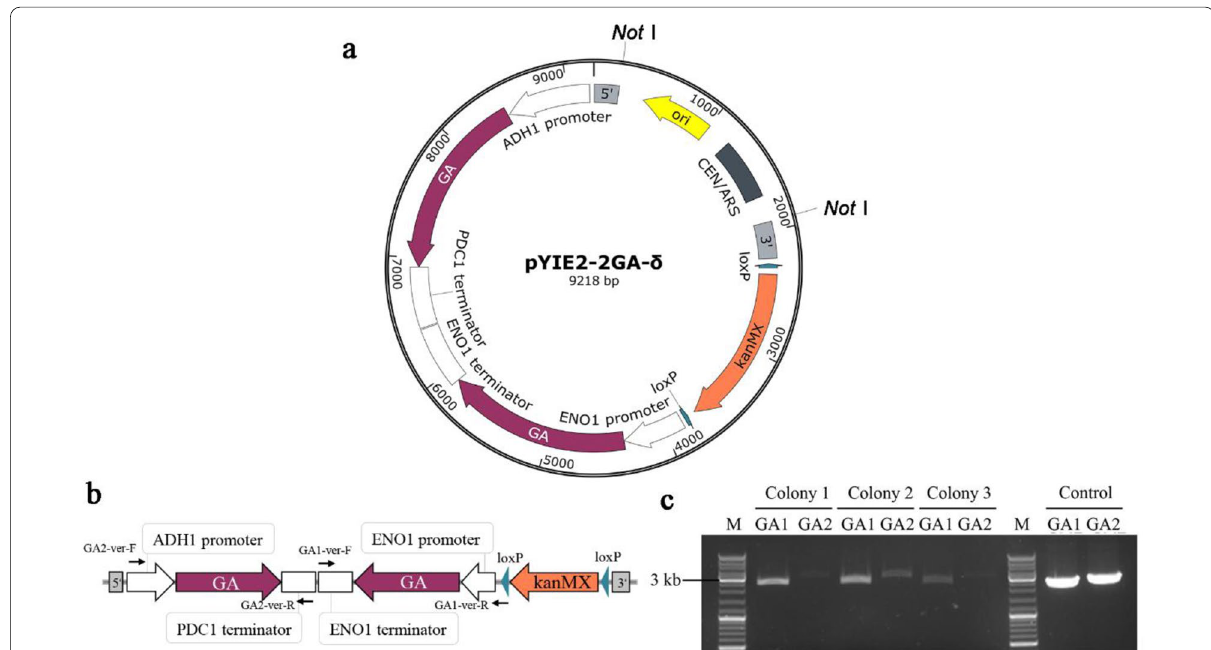
Fig. 1 Construction of S . fibuligera derived glucoamylase expressing industrial S. cerevisiae strain. The map of the pYIE2-2GA-δ plasmid ( a ), the 5 ′ and 3 ′ were referred to as the up and down homology arm of the delta sequence, respectively. The Not I-linearized two copies of the GA expression cassette ( b ) and the agarose gel electrophoresis map of the verification of the GA integration, three transformants were picked randomly ( c ). GA1: P ENO1 -GA- T ENO1 cassette. GA2: P ADH1 -GA- T PDC1 . Control: pYIE2-2GA-δ plasmid. M: DNA marker. GA: